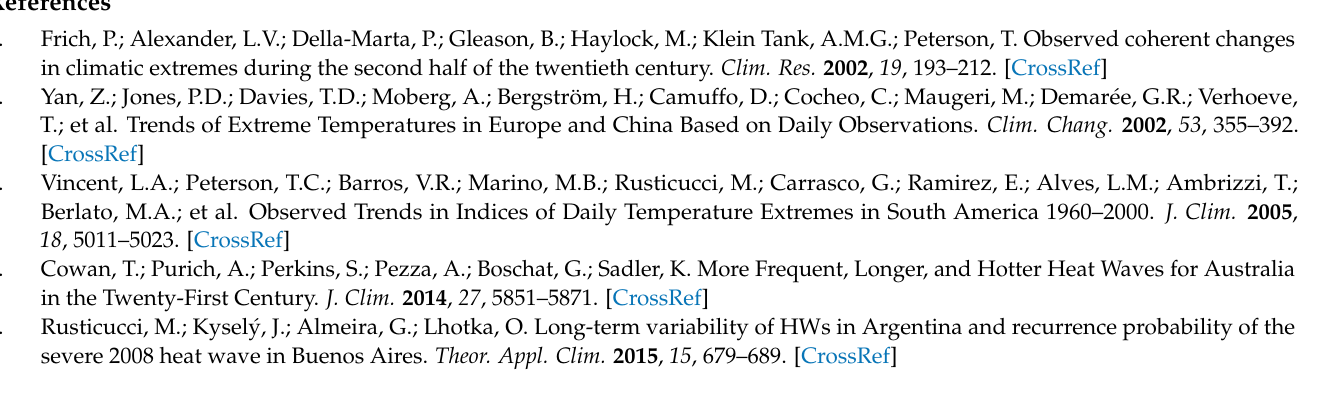
Table 1) in Serbia from 1949 to 2018, Table S2: Seasonal trend coefficients of Tx for 11 stations (listed in Table 1) in Serbia from 1949 to 2018, Table S3.1: Absolute and average number (avg) of SU (days) for 11 stations in spring in Serbia from 1949 to 2018, Table S3.2: Absolute and average number (avg) of SU (days) for 11 stations in summer in Serbia from 1949 to 2018, Table S3.3: Absolute and average number (avg) of SU (days) for 11 stations in autumn in Serbia from 1949 to 2018, Table S4.1: Absolute and average number (avg) of Tx90 (days) for 11 stations in spring in Serbia from 1949 to 2018, Table S4.2: Absolute and average number (avg) of Tx90 (days) for 11 stations in summer in Serbia from 1949 to 2018, Table S4.3: Absolute and average number (avg) of Tx90 (days) for 11 stations in autumn in Serbia from 1949 to 2018, Table S4.4: Absolute and average number (avg) of Tx90 (days) for 11 stations in winter in Serbia from 1949 to 2017, Table S5.1: Absolute and average number (avg) of FD (days) for 11 stations in spring in Serbia from 1949 to 2018, Table S5.2: Absolute and average number (avg) of FD (days) for 11 stations in autumn in Serbia from 1949 to 2018, Table S5.3: Absolute and average number (avg) of FD (days) for 11 stations in winter in Serbia from 1949 to 2017, Table S6.1: Absolute and average number (avg) of Tn10 (days) for 11 stations in spring in Serbia from 1949 to 2018, Table S6.2: Absolute and average number (avg) of Tn10 (days) for 11 stations in summer in Serbia from 1949 to 2018, Table S6.3: Absolute and average number (avg) of Tn10 (days) for 11 stations in autumn in Serbia from 1949 to 2018, Table S6.4: Absolute and average number (avg) of Tn10 (days) for 11 stations in winter in Serbia from 1949 to